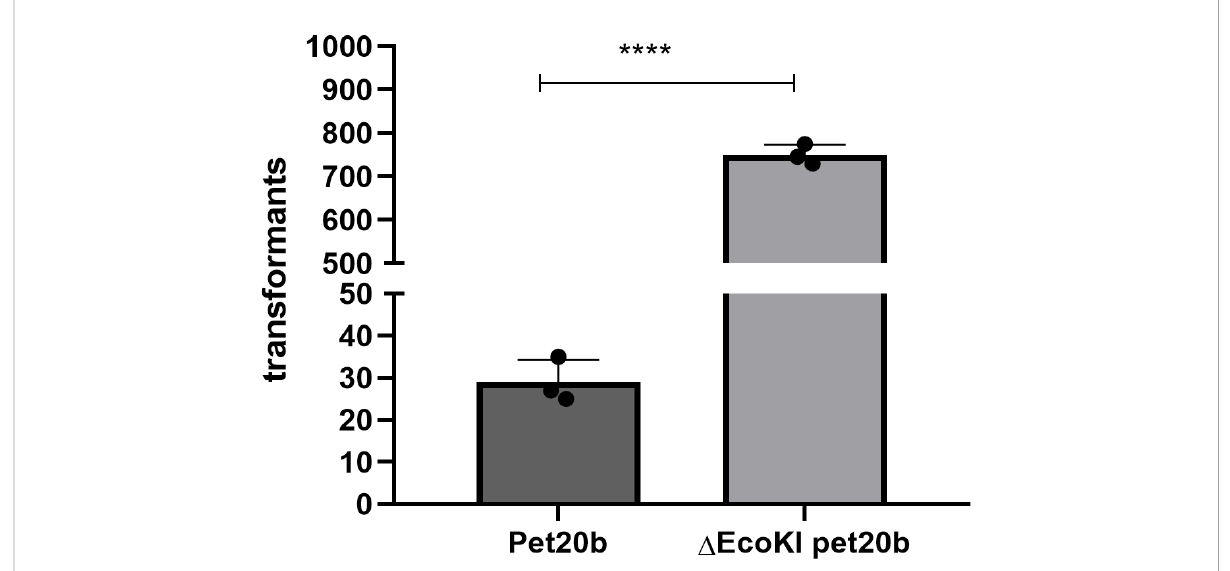
FIGURE 4 Restriction enzyme recognition site and transformation ef fifi cacy. E. coli strain (NM1049, EcoKI+) transformed with wild-type plasmid pet20b and Pet20b that lacks one restriction enzyme recognition sites. The number of transformants is indicated. Data are the means ± SD derived from three repeated experiments. ****Signi fifi cantly greater than wild-type; P < 0.001.